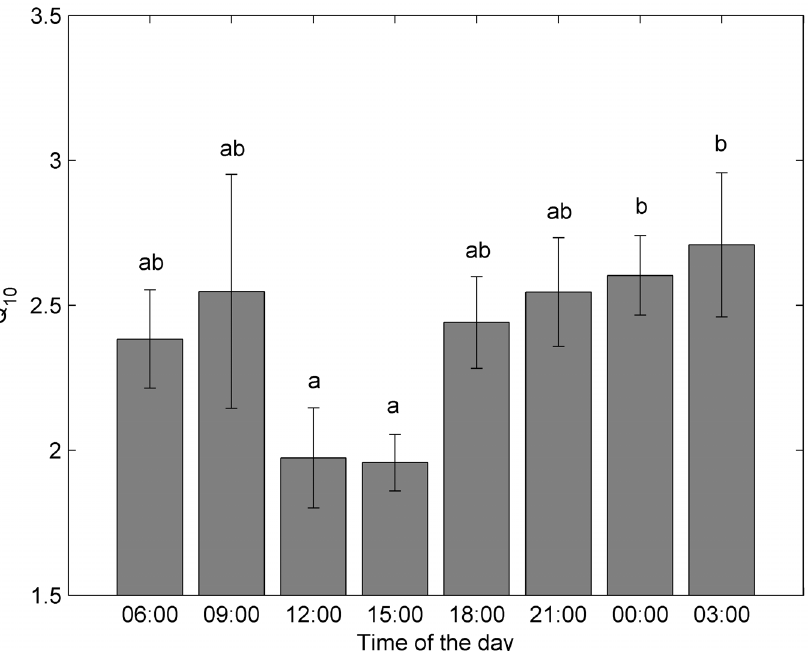
Figure 5. The diurnal variations of Q 10 estimated based on the seasonal variation in R S at different time during one day. Values not given a common letter are significantly different from each other at P=0.05. Bars represent the standard